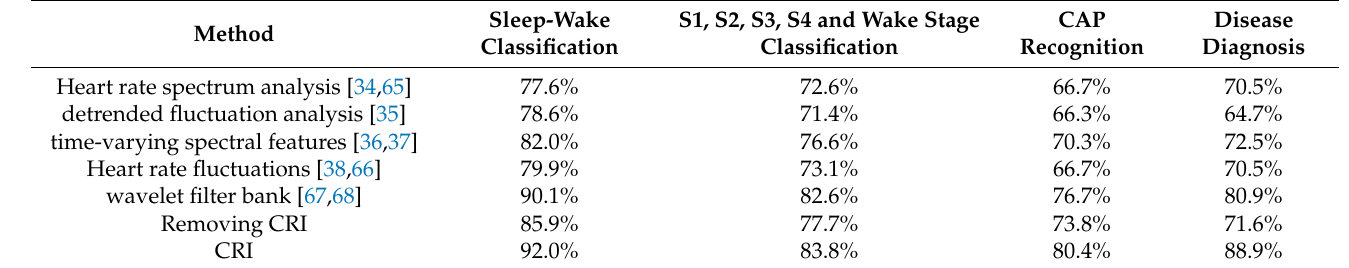
Table 3. The F1 scores of CRI and features of other studies in experiments of sleep stage classification and disease